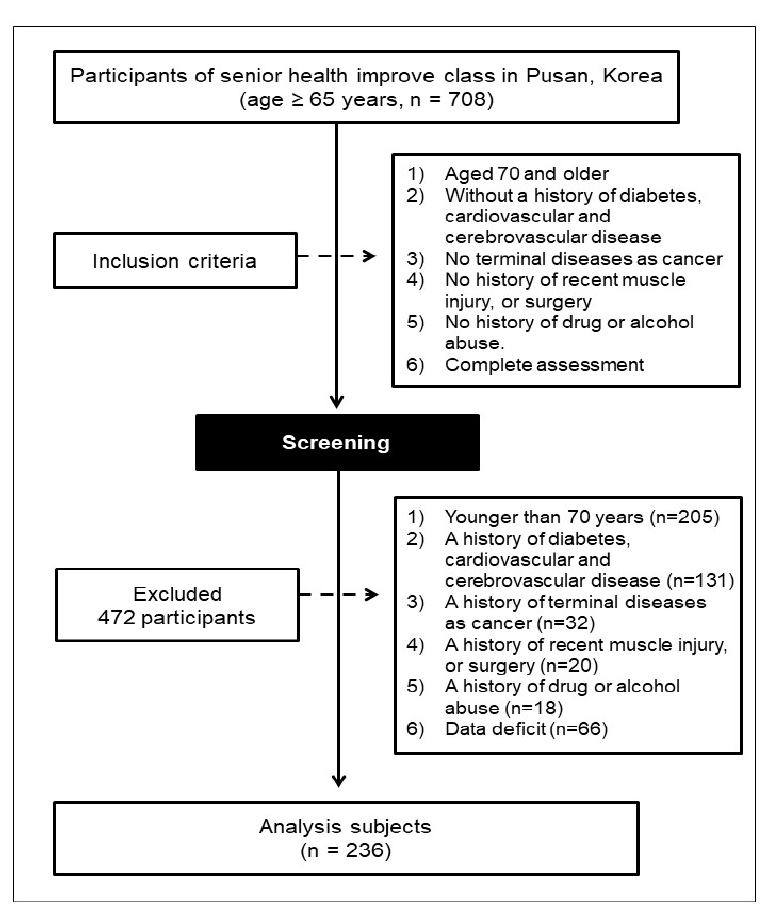
Figure 1. Flow diagram of the enrollment and classification of the study participants.